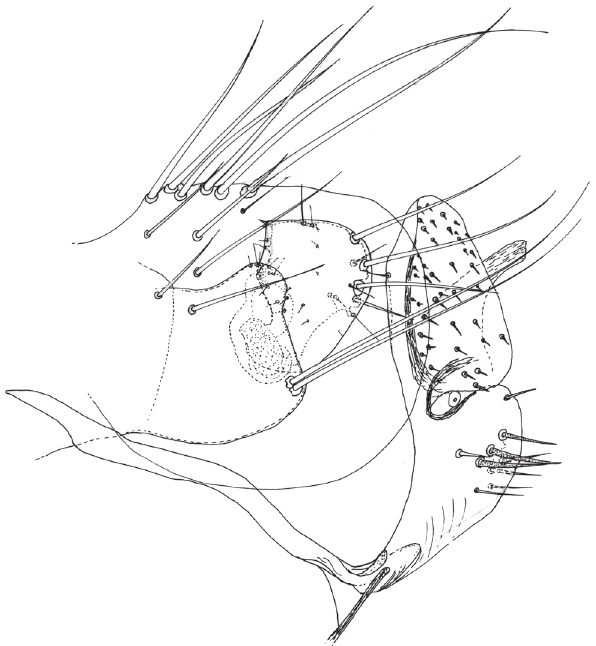
).Figure 6. – Nosopsyllus (N.) incisus traubi n. ssp. Tergite VIII et segment IX du  holotype sur Dendromus sp., Dinshu, Parc National Mts Bale (Éthiopie), 3 017 m, 21 février 1973 (R. Traub & J. Ash rec.